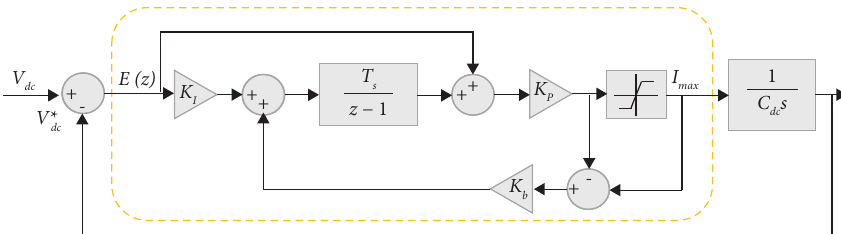
Figure 3: HDL blocks of the discrete IP antiwindup regulator. Table 1: IP antiwindup controller